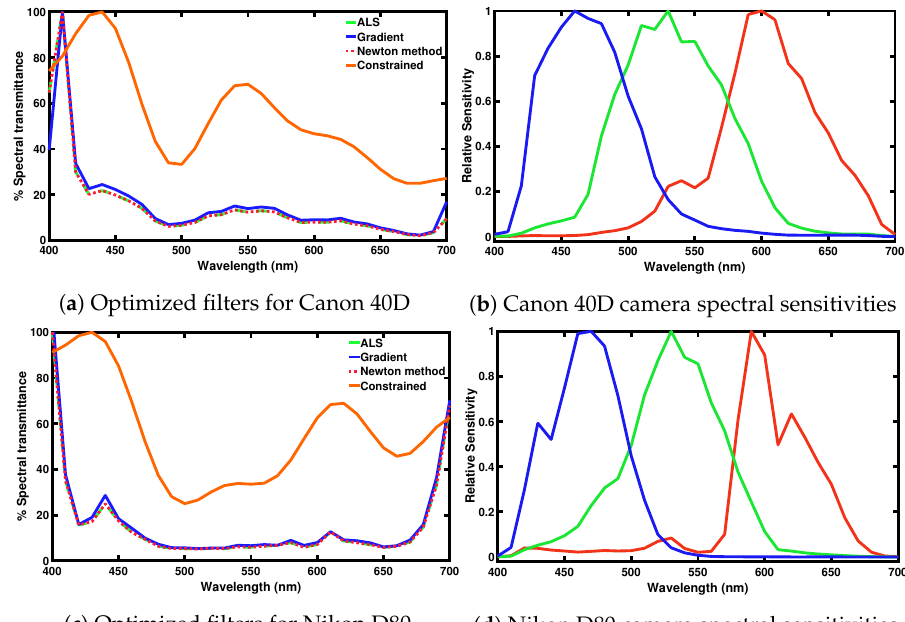
Figure 3. ( a , c ): Spectral transmittance of the derived optimized filters for a Canon 40D and a Nikon D80 DSLR cameras, respectively. The optimized transmissive filters are solved from the algorithms of the Alternating Least-Squares (solid green), gradient (solid blue) and Newton’s method (dotted red). The orange curves show the smoothness-constrained filters (that are described by the first 8 terms in a Cosine basis expansion) where they must transmit at least 25% of the light. ( b , d ): Camera spectral sensitivity curves of Canon 40D and Nikon D80